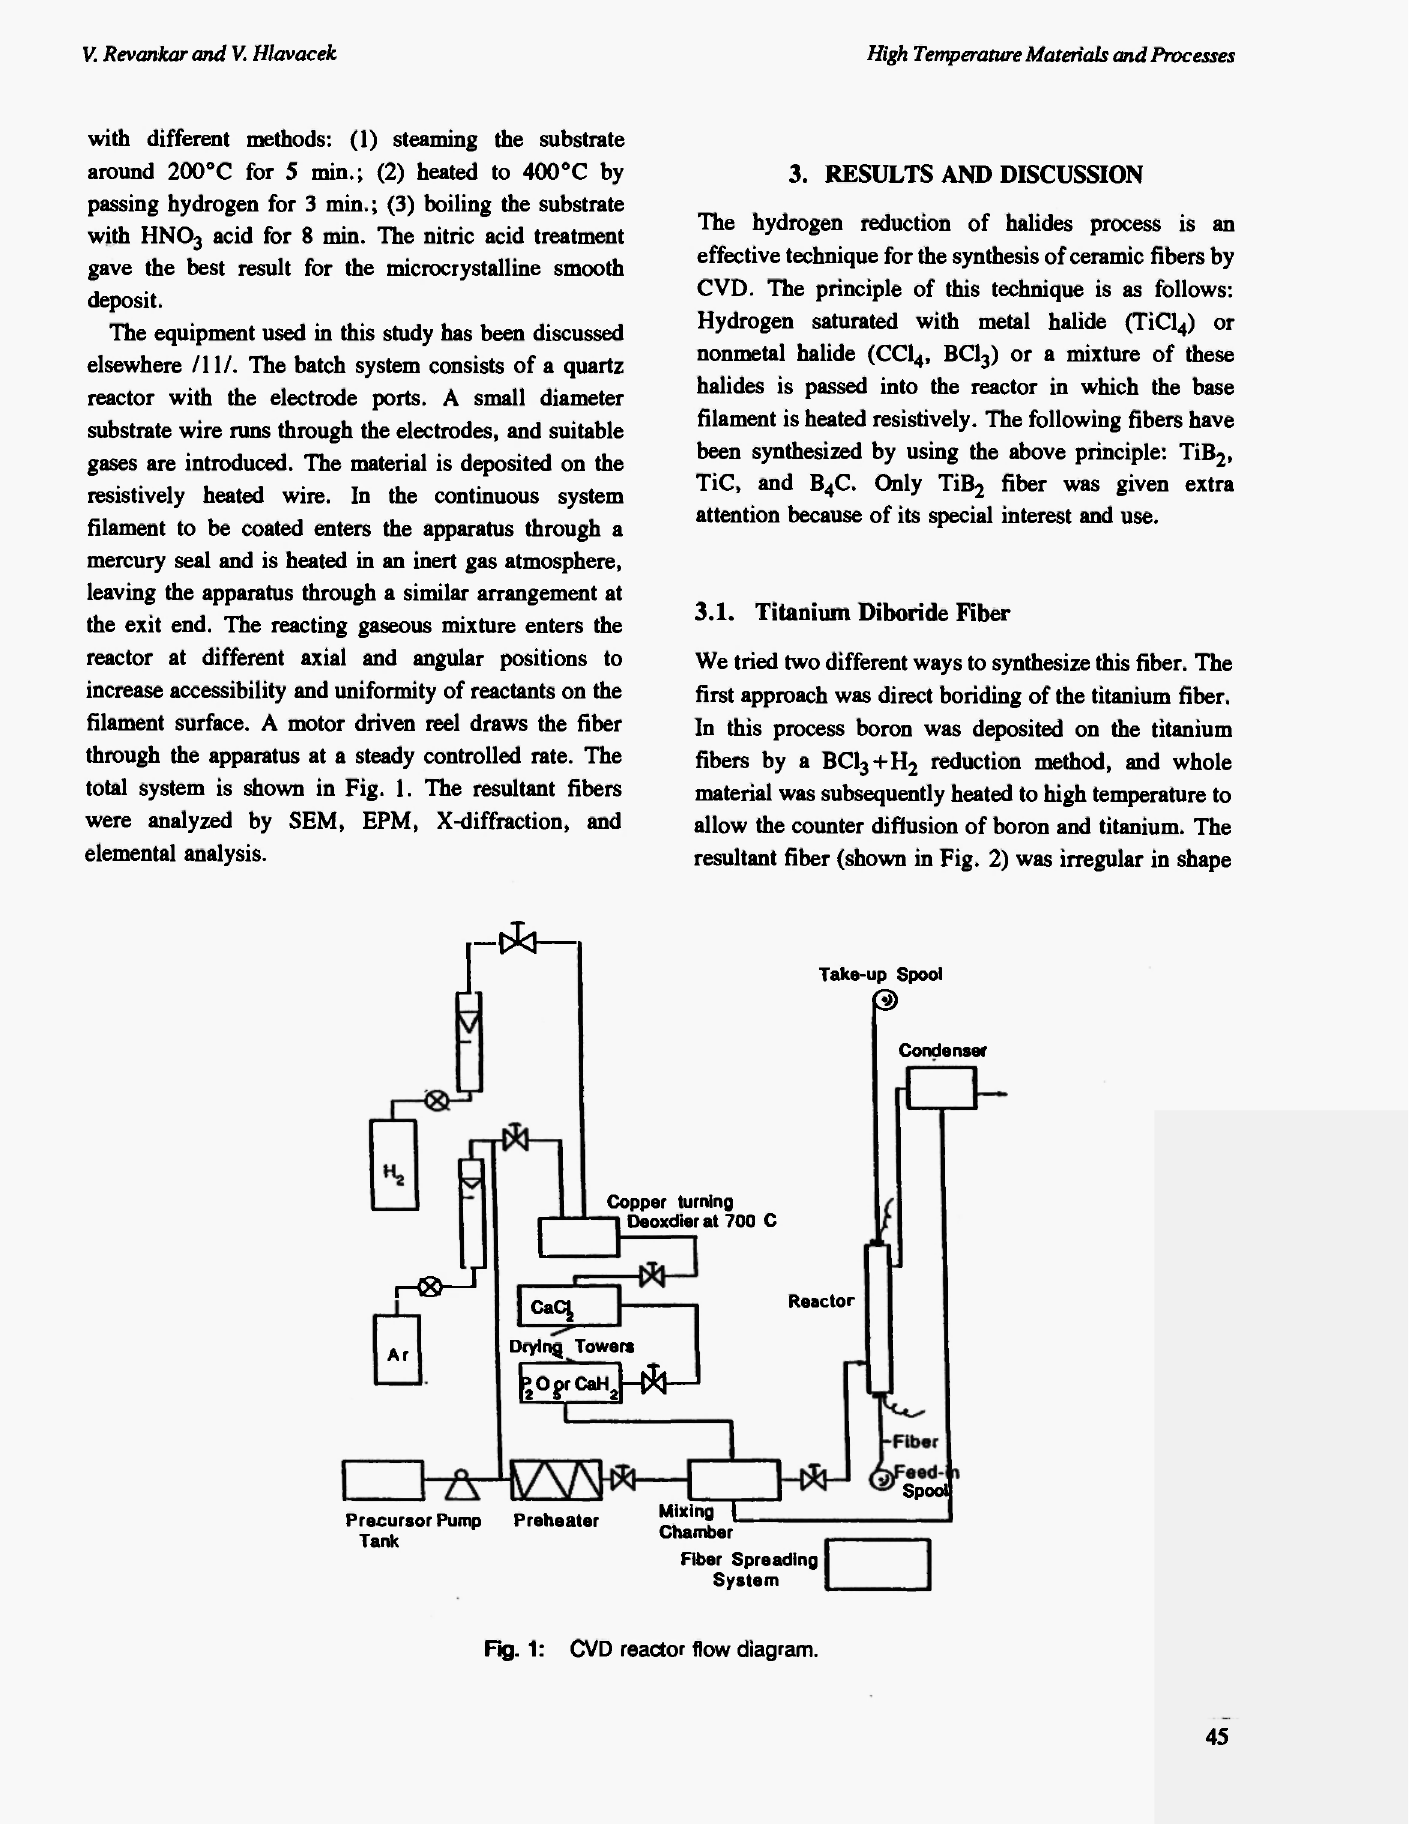
Fig. 1: CVD reactor flow